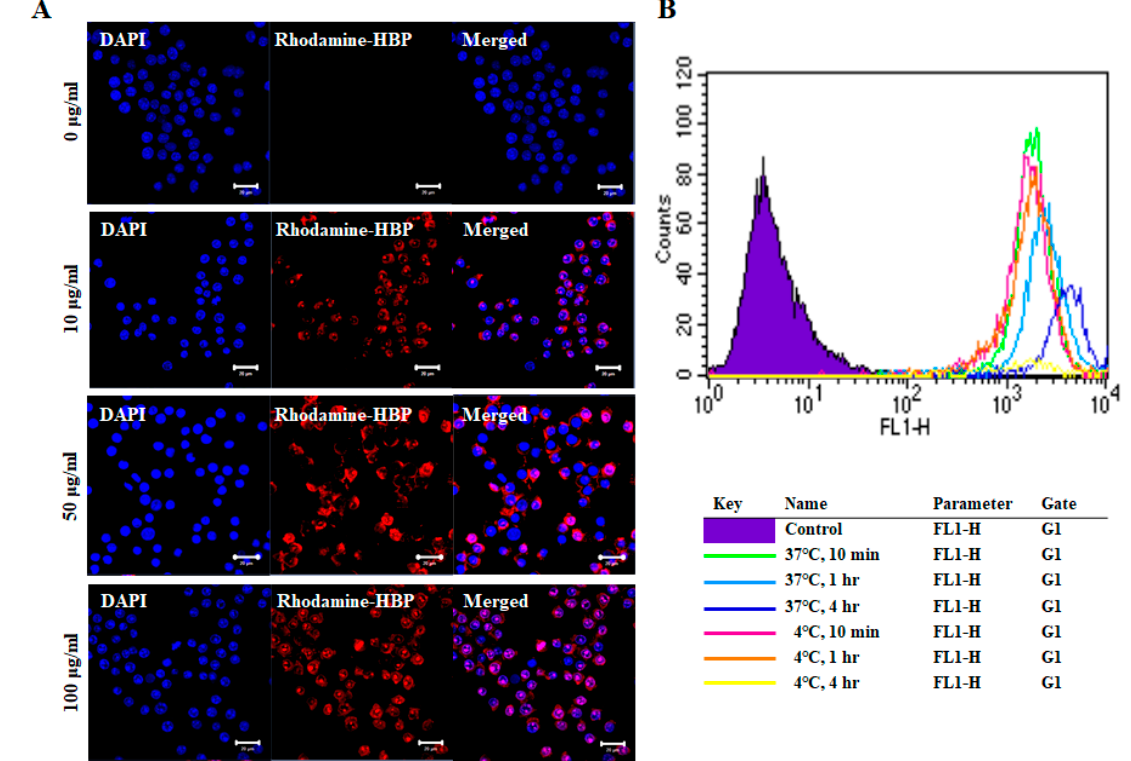
Figure 2. Images of intracellular HBP uptake in RAW264.7 cells. ( A ) Rhodamine-labeled HBP was detected in RAW264.7 cells via confocal microscopy. Intracellular HBP localization was increased in a dose-dependent manner (Scale bar = 20 µm, n = 3). ( B ) Fluorescence-activated cell sorting (FACS) analysis of differences in cellular uptake of HBP under different culture conditions, including temperature (4 °C, 37 °C) and incubation time (10 min, 1 h, and 4 h).